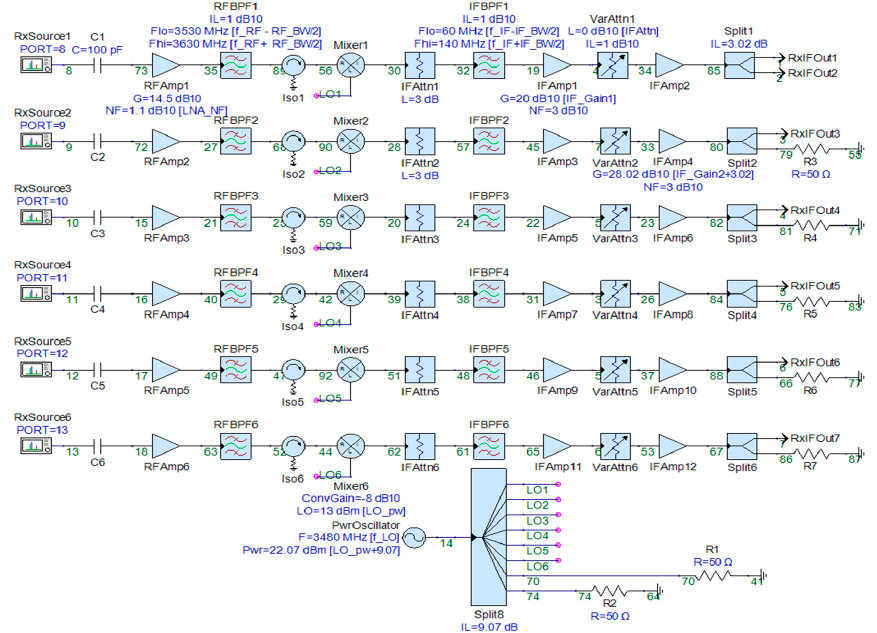
Figure A5. Six RF down-converter model of the RESM receiver. Table A1. Parmeters Used RF TX and RX Models.